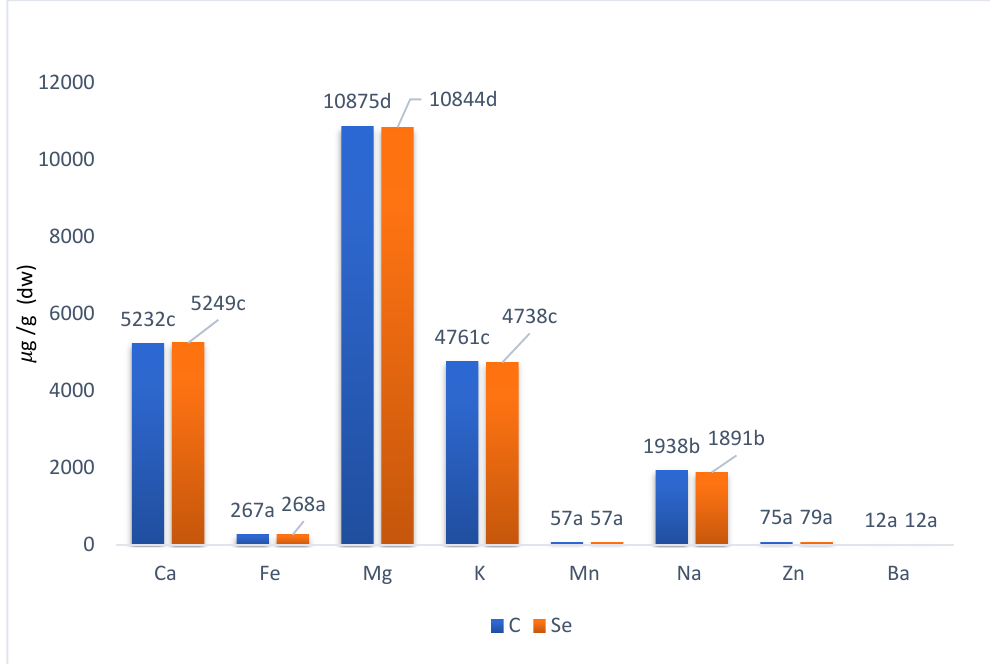
Figure 6. Mineral elements content (dw—dry weight) in all tested microgreens species after fortification with sodium selenate. C—control variant; Se—selenium application (2 mg Se/L). Values are the average content of mineral substances within all tested species (SD), the different letters represent statistically significant differences between the observed varieties and variants at p < 0.05 by LSD in ANOVA (Statgraphic XVII).